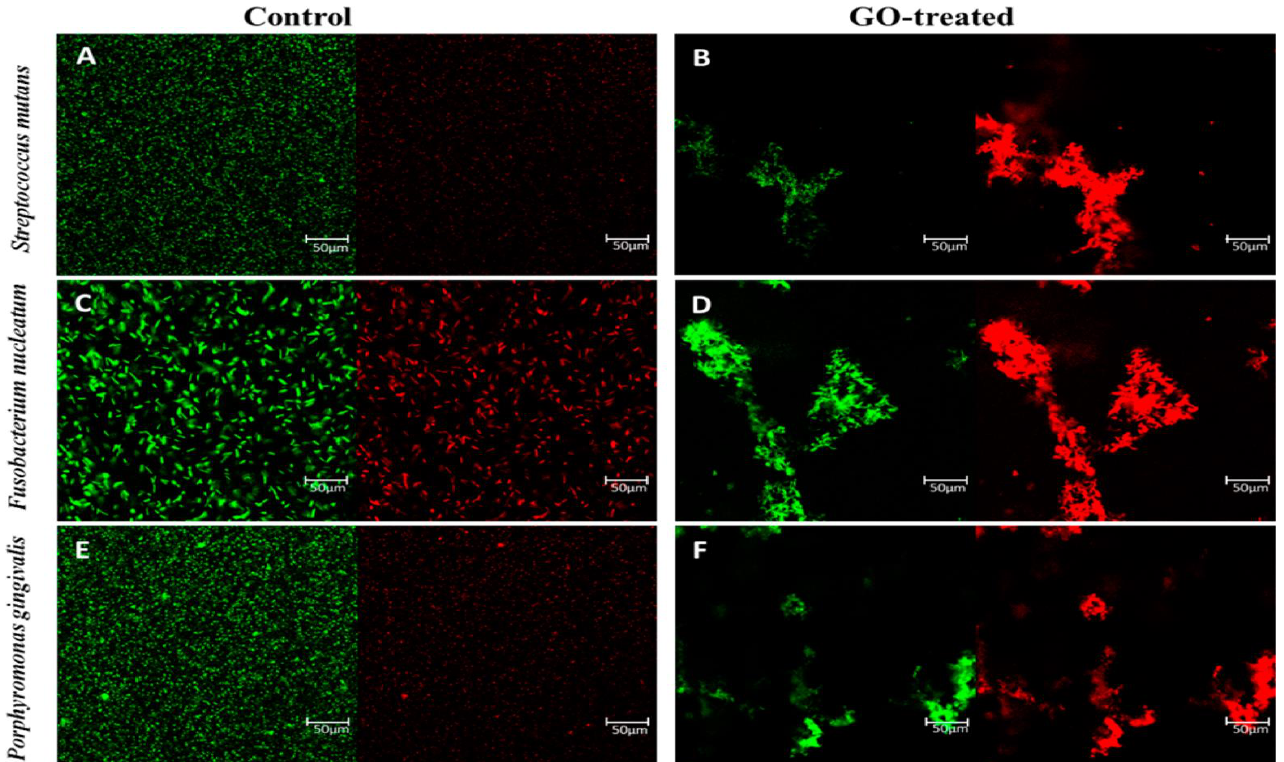
Figure 5. Images of fluorescent stains that are both alive and dead. S. nutans ( A – D ), F. mutans, and P. gingivalis cells ( E , F ) were treated for 2 h with GO nanosheets and isotonic saline (control). Representative fluorescence microscopy pictures of bacteria cells stained for 15 min in the dark with SYTO 9 (green channel) and PI (red channel). The identical GO dosage of 80 g/mL was given to all of the patients. The scale bar is 50 μm [70].